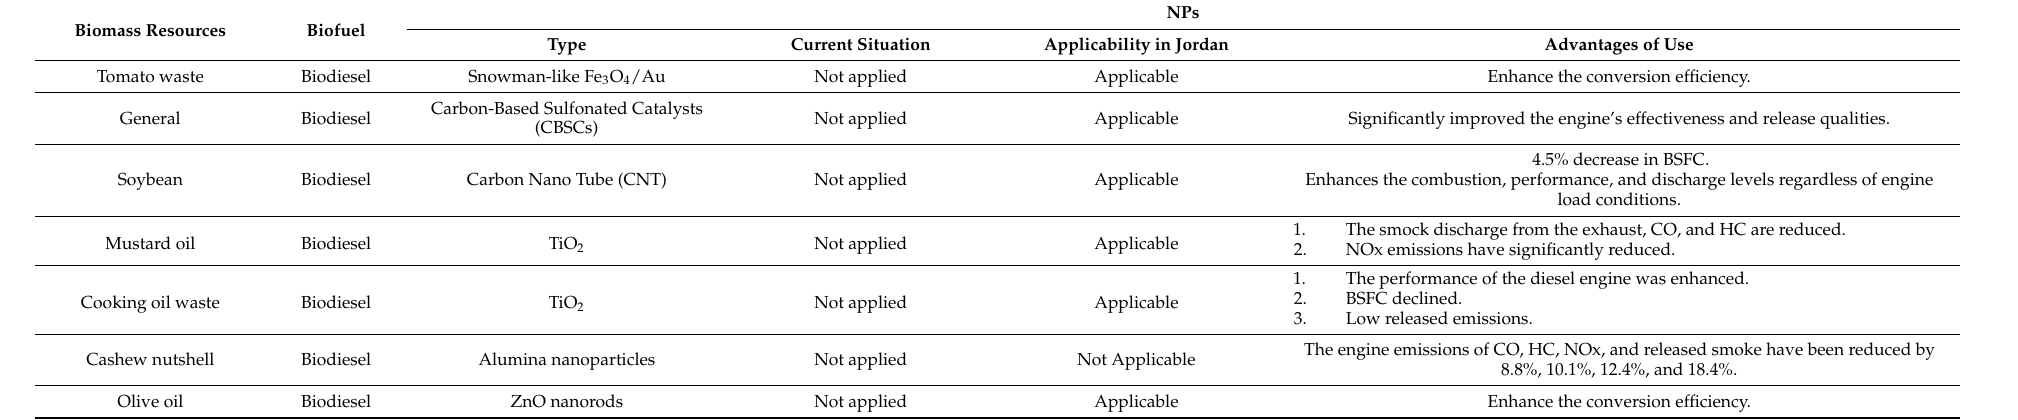
Table 15. Possibility of bioenergy production and blending with nanotechnology from some biomass resources in